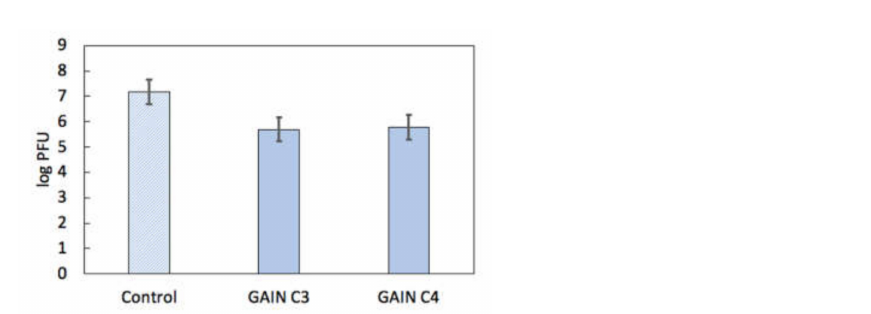
Figure 7. HPeV1 adherence results for GAIN scaffolds (log plaque-forming units (PFU) scale). Error bars show standard